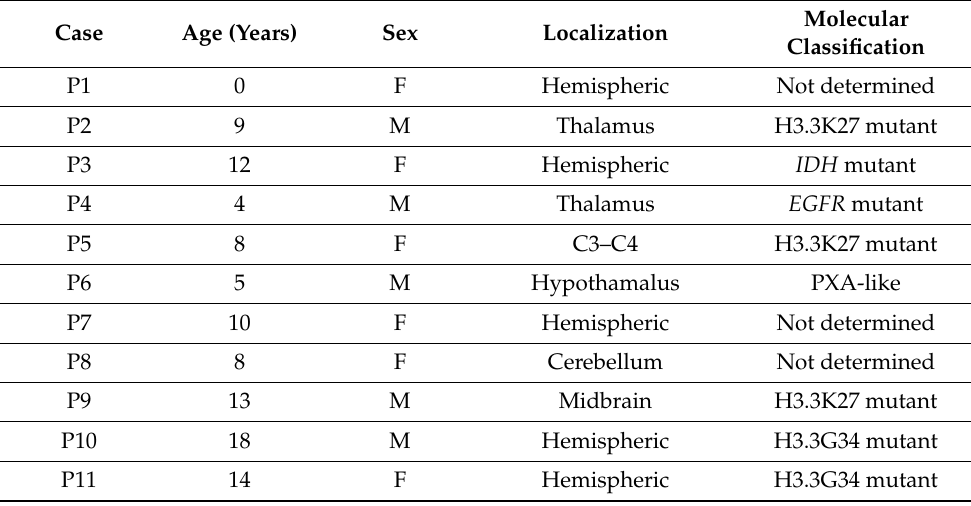
Table 1. Clinical data and molecular classification. F: female; M: